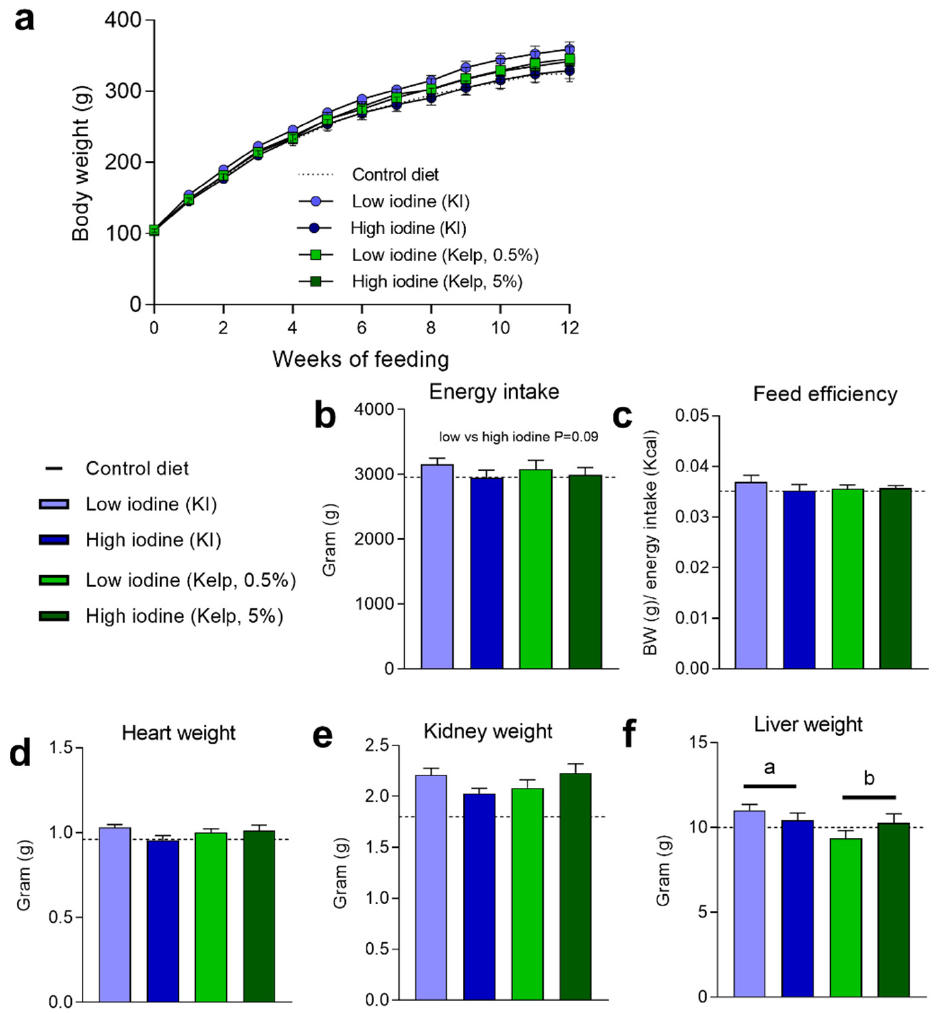
Figure 4. ( a ) Body weight development, ( b ) energy intake, ( c ) feed efficiency, ( d ) weight of heart, ( e ) kidney and ( f ) liver after 13 weeks of dietary treatment. Data are presented as mean ± SEM ( n = 5). Different letters (a,b) in the graph denote significant differences ( p < 0.05) between the iodine sources (kelp, KI). Data were analysed by a standard two-way ANOVA in GraphPad Prism.